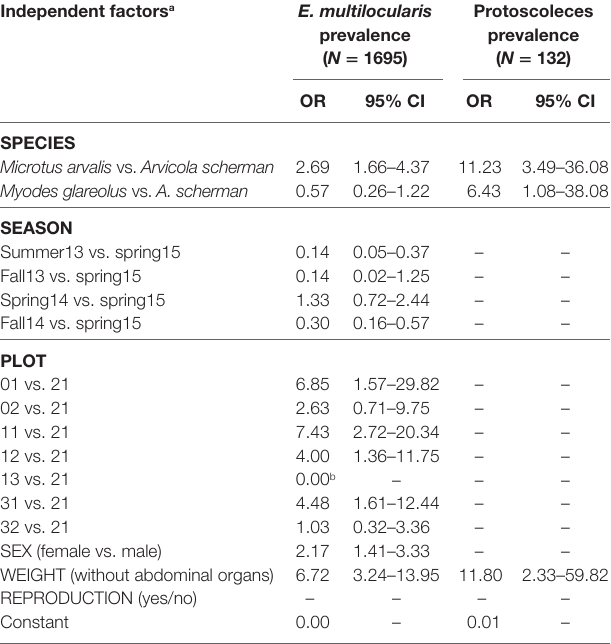
Table 1 | Odds ratios and the corresponding 95% CI of the best logistic regression models for (a) Echinococcus multilocularis prevalence in the most frequently trapped rodent species ( Arvicola scherman , Microtus agrestis and Myodes glareolus ) and (b) percentage of fertile infection (containing protoscoleces) out of all Echinococcus multilocularis positive